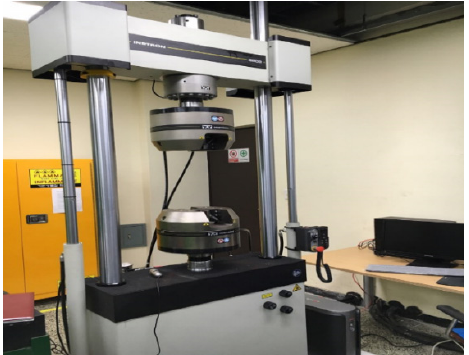
Figure 11. IMT 8002 Servo hydraulic fatigue-testing machine.